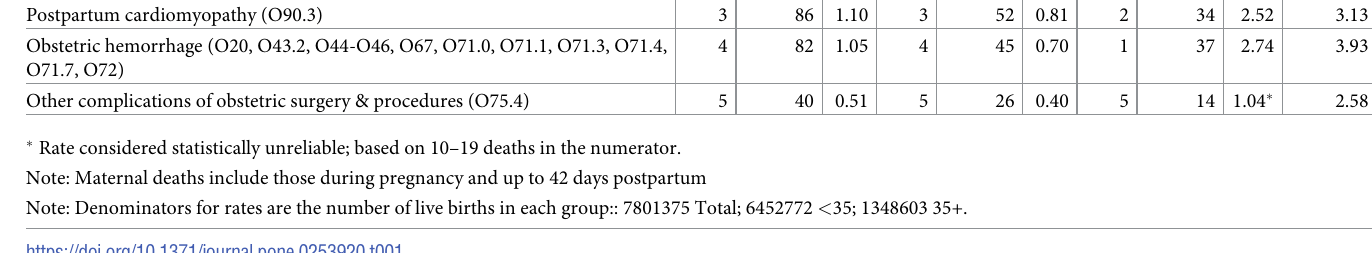
Compared to women < 35 years of age, the confirmed maternal mortality rate was twice as high for women aged 35–39 (mortality rate ratio (MRR) = 1.98), four times higher for women (Fig 1). For the total population, obstetric embolism and eclampsia/preeclampsia were tied for the leading cause of maternal death (Table 1). The obstetric embolism category includes amniotic fluid, pulmonary, and any other embolism occurring during the pregnant/postpartum period. The third leading cause of death was postpartum cardiomyopathy, followed by obstetric hem- orrhage, and other complications of obstetric surgery and procedures. About 2/3 (65.7%) of confirmed maternal deaths were due to one of these five causes. Table 1. Five leading causes of confirmed maternal death by maternal age, United States, 2016–2017. Total 1 Maternal age < 35 Maternal age 35+ Rate ratio Primary cause of death (ICD-10 code)